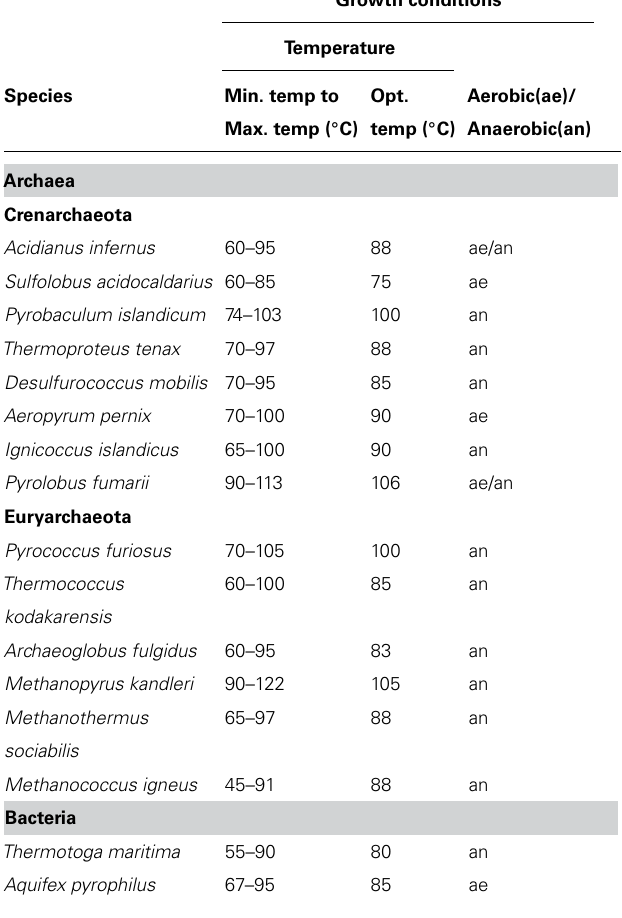
Table 1 | Representative